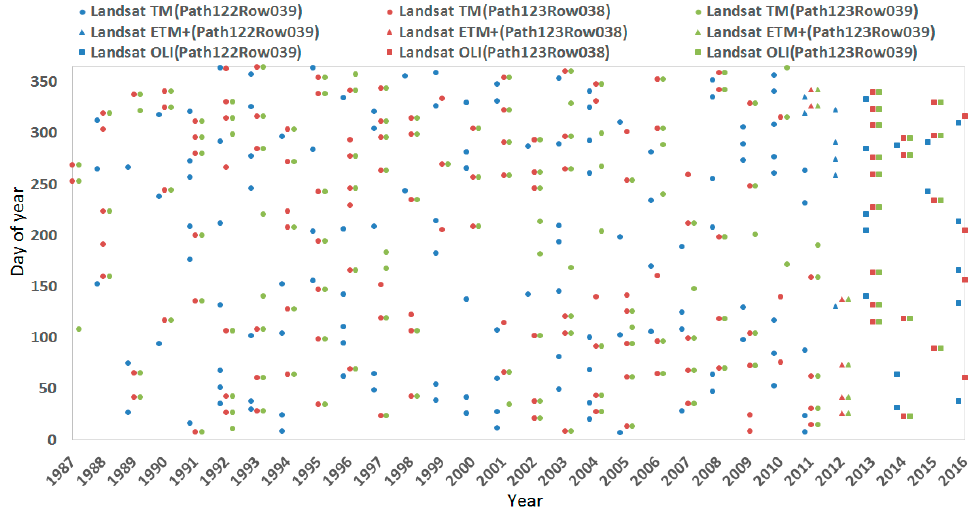
Figure 2. Temporal distribution of Landsat scenes.